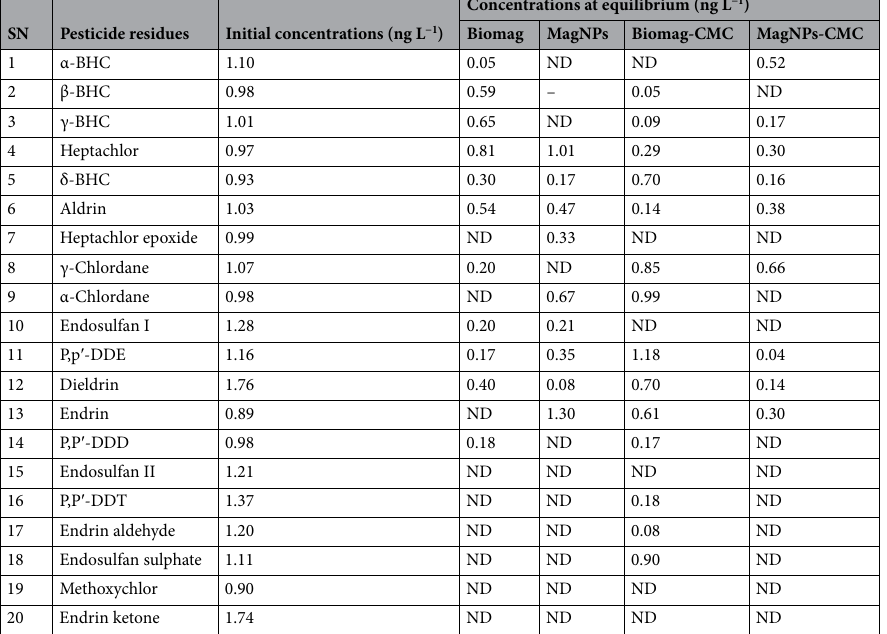
Table 6. Initial and final concentrations of residues in pesticide wastewater. ND not